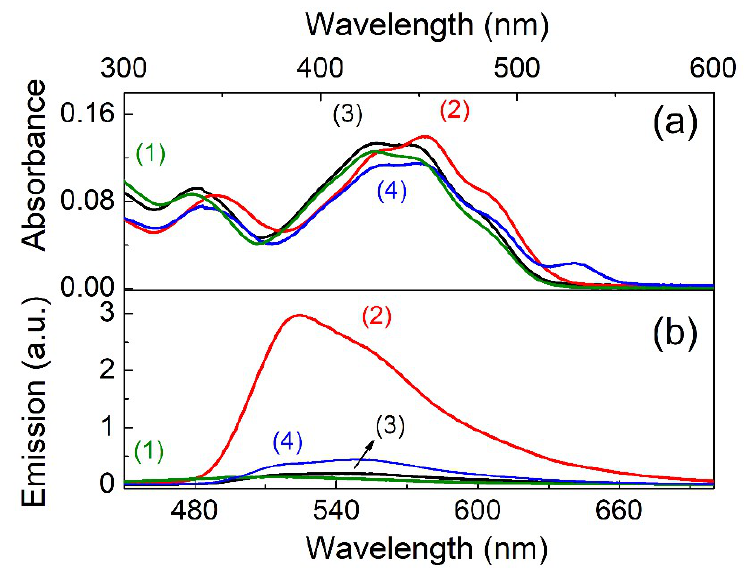
Figure 2. ( a ) Absorbance and ( b ) emission spectra of compound 1 in different solvents (concentration of 1 × 10 − 5 mol/L): (1) Tetrahydrofuran (THF), (2) ethanol, (3) acetonitrile, and (4) dimethylsulfoxide (DMSO). As shown in Table 1, the dielectric constants ( ε r ) of the studied solvents ranged from 7.52 (THF) to 47.2 (DMSO). The observed molar absorptivity values of 1 and 2 did not vary appreciably in the different solvents and thus could not be correlated with a solvent effect. Figure 3a presents the peak absorbance ( λ abs ) of compounds 1 and 2 versus the dielectric constant of the various solvents, and a bathochromic shift in absorption peak was observed as a function of ε r in both compounds. In compound 2 , a deviation from the expected trend of increase was observed between ethanol and acetonitrile (Figure 3a). This finding can be rationalized regarding the prevailing type of force underlying the compound/solvent interaction. The sulfur atom amino acid side chain in 2 is poorly electronegative; thus, ethanol (a protic solvent) is better able to stabilize the compound via its HBP